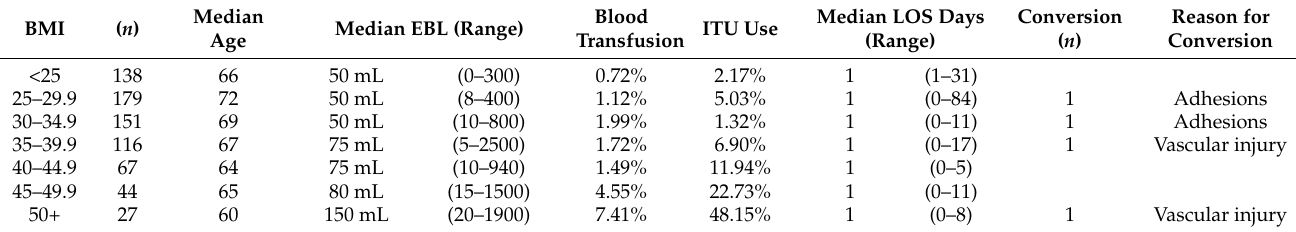
Table 2. Robotic cohort—Surgical outcomes and